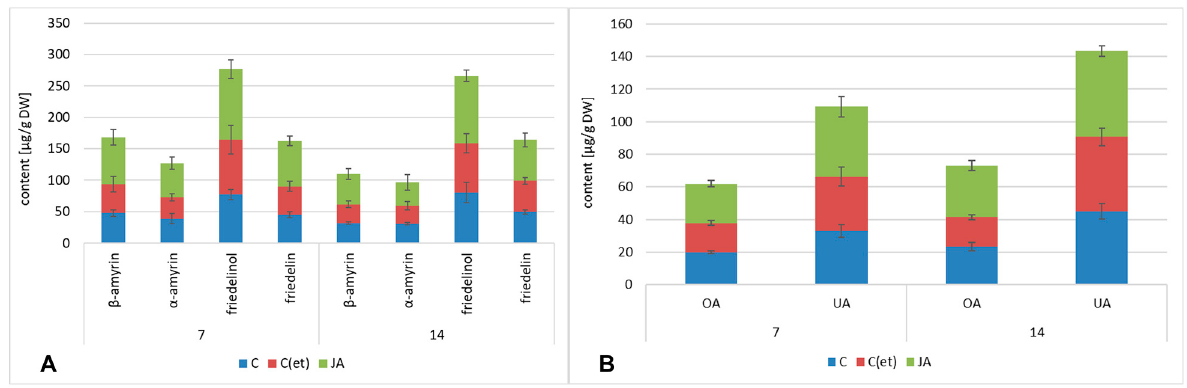
Figure 13. The content of neutral triterpenoids ( A ) and free acids ( B ) in C. officinalis roots. C—control, C(et)—control samples treated with the adequate volume of 70% ethanol, JA—jasmonic acid-elicited samples. See detailed data and statistical significance in Table S15.